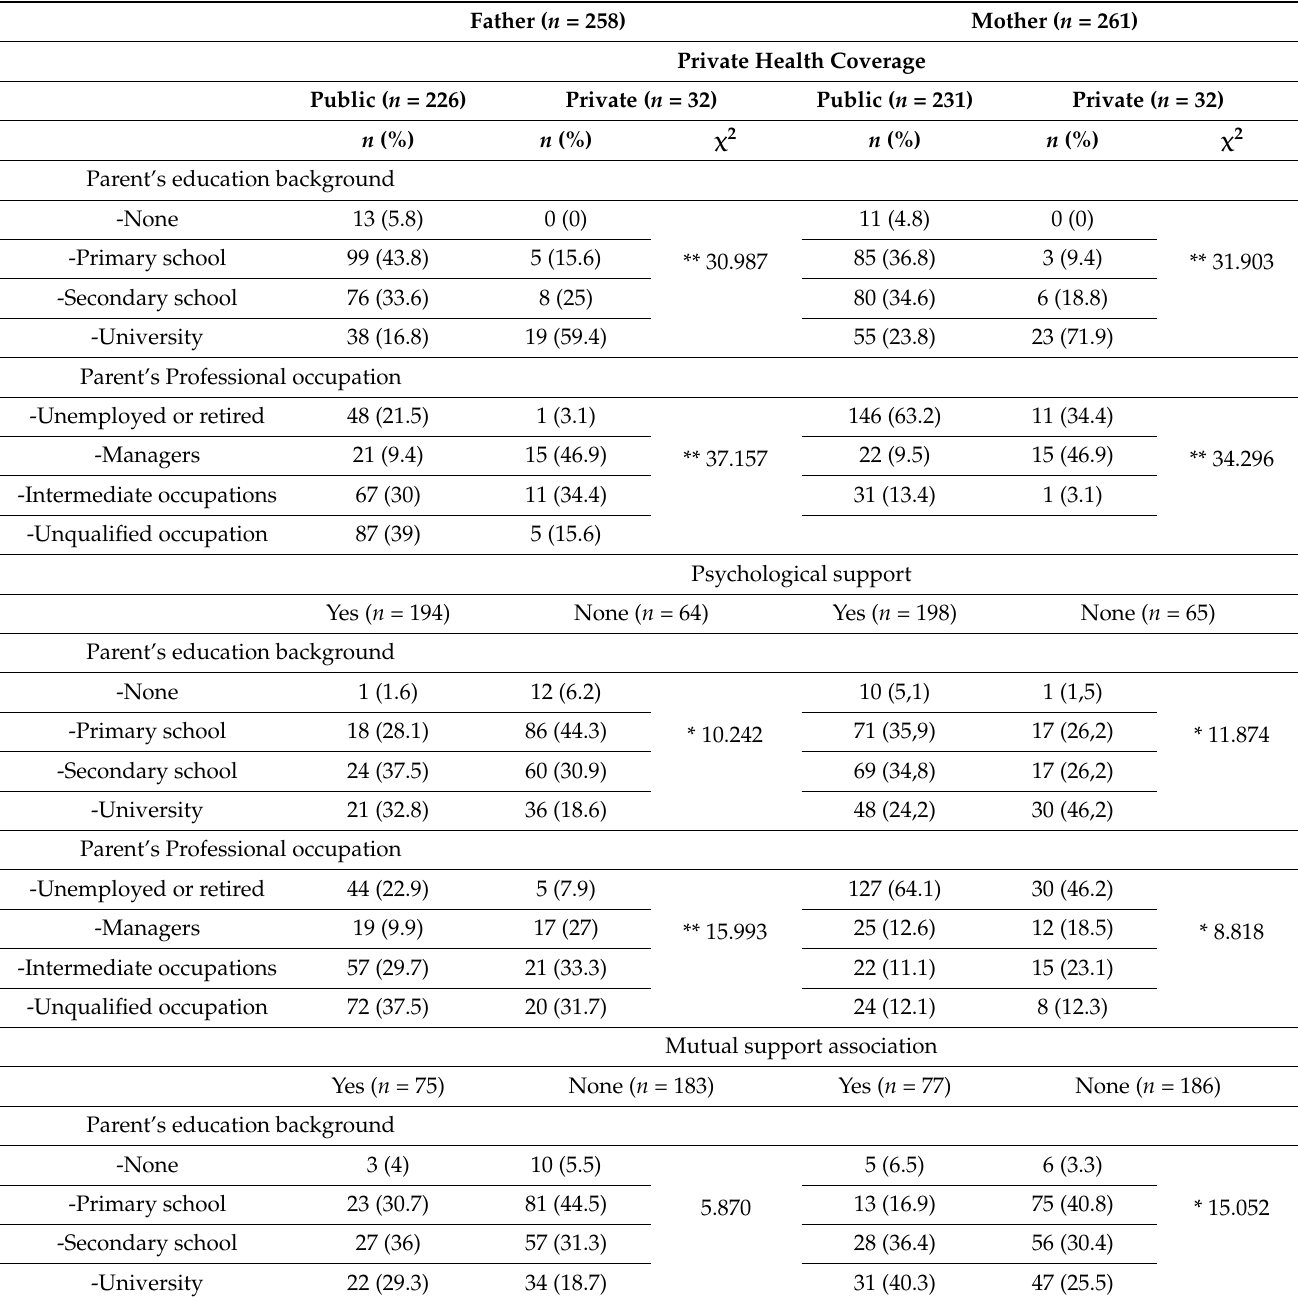
Table 2. Health care utilization and sociodemographic